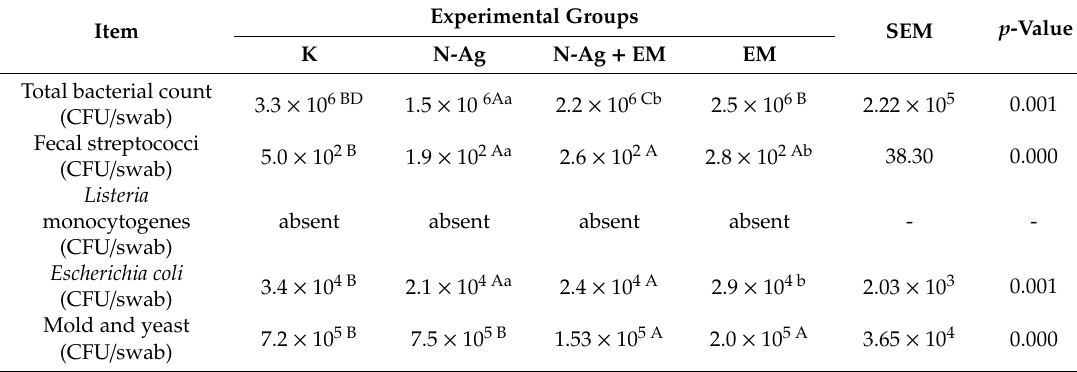
Table 2. Means of measurements of microbiological community of swabs taken from the surface of feed tables in the control and experimental